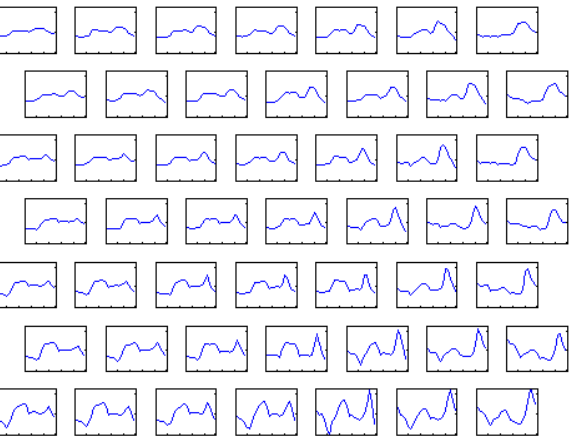
Figure 4. The exemplary patterns of the load profiles in the power system generated by the Kohonen network at the application of 49 neurons. Each neuron is represented by the 24 weights corresponding to the center vector of the cluster.